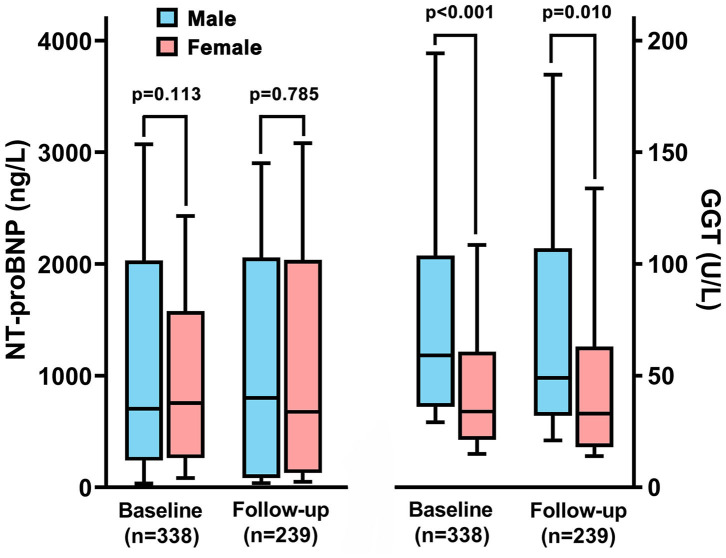
The changes of N-terminal pro B-type natriuretic peptide (NT-proBNP) and gamma-glutamyltranspeptidase (GGT) between male and female patients in baseline and rehospitalization.